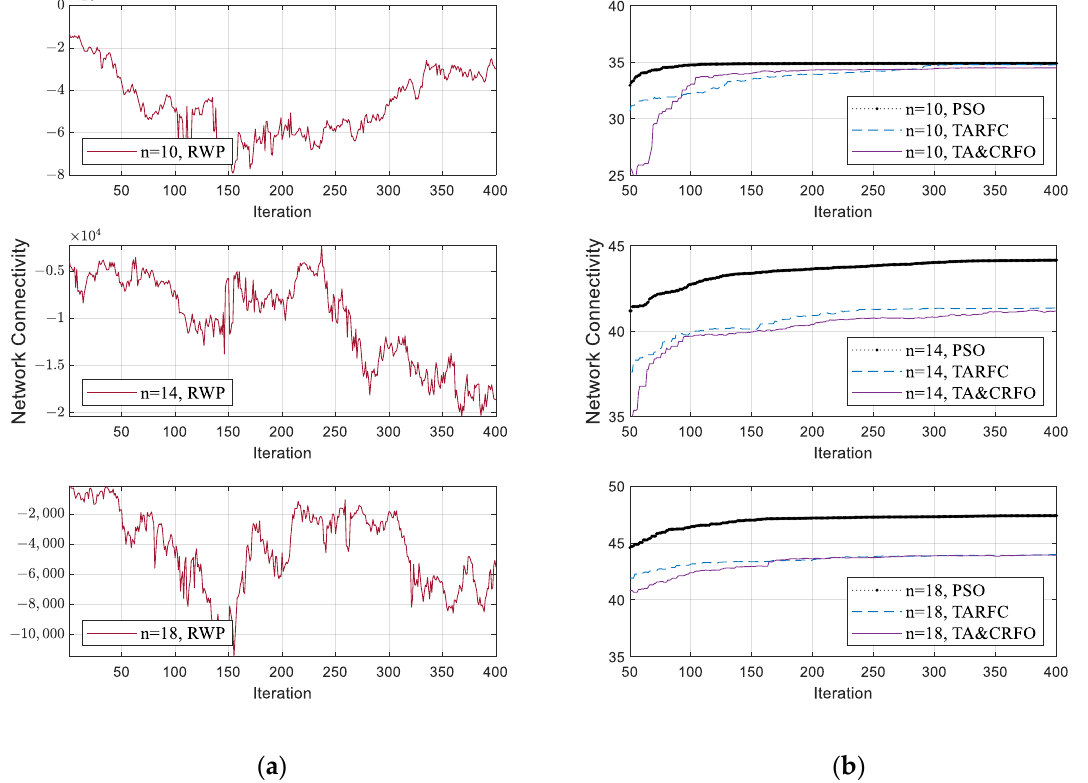
Figure 8. The Network Connectivity fluctuation of algorithms in the iterative process of FANET construction: ( a ) The fluctuation of the RWP algorithm; ( b ) The fluctuation of other